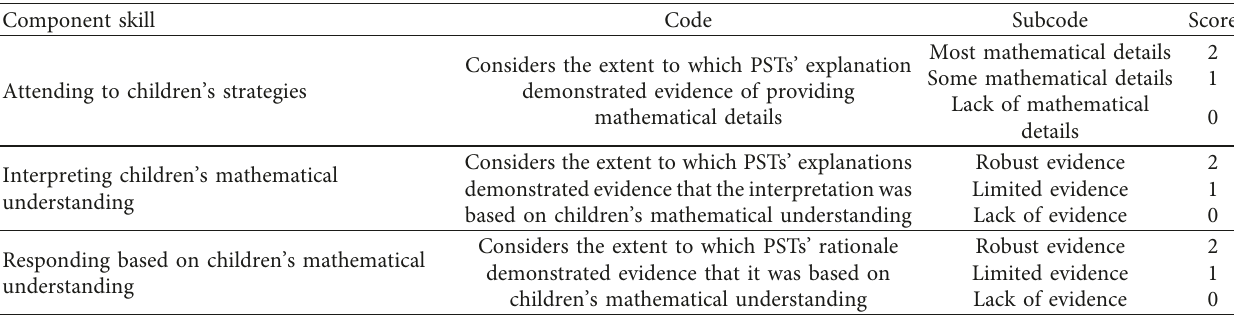
Table 5: Description of the coding